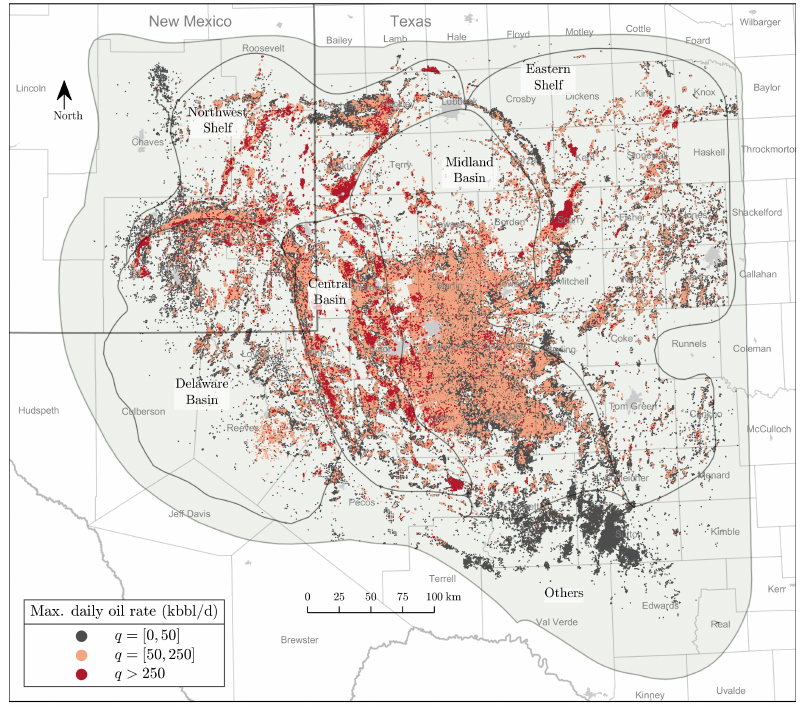
Figure 4. The map of all 484,759 vertical wells in the Permian Basin, colored by three classes of maximum daily oil rate.